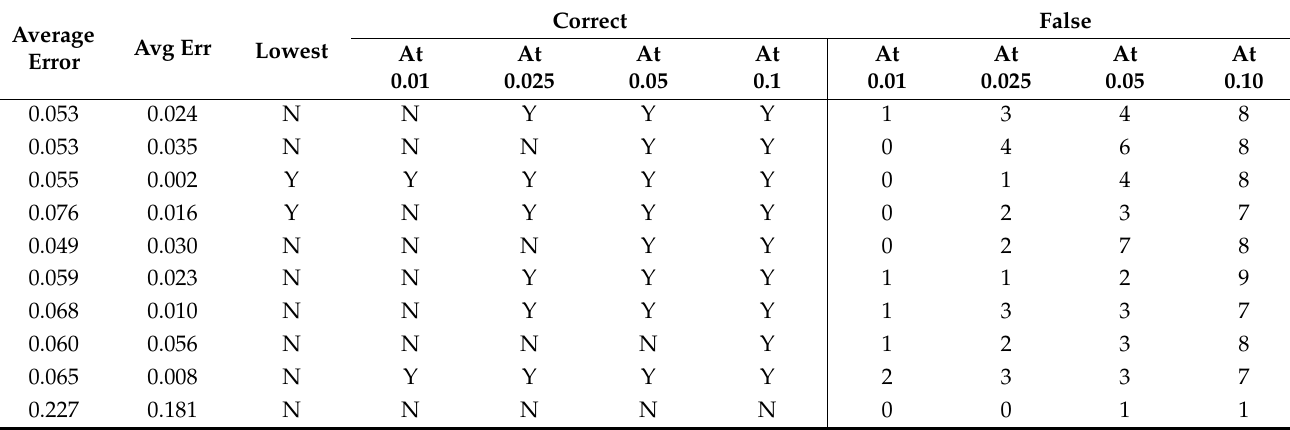
Table A46. Set 1, trials 21–30 summary data (average actual PR